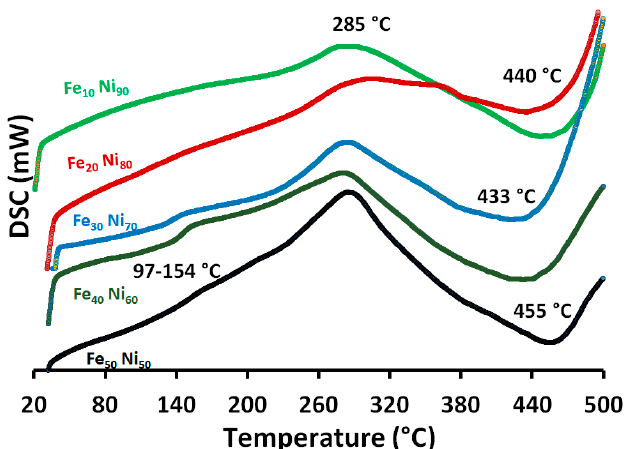
Figure 9. The DSC diagram of the prepared iron-nickel alloys using different iron-nickel molar ratio (10–50% Fe). Reaction reference: 0.1 M metal concentration, 80 mL reaction volume, 1400 rpm, and 95–98 °C.